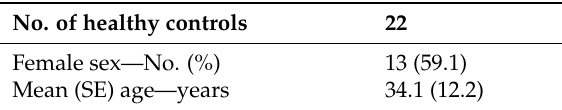
Table 1. Summary of healthy control demographics.